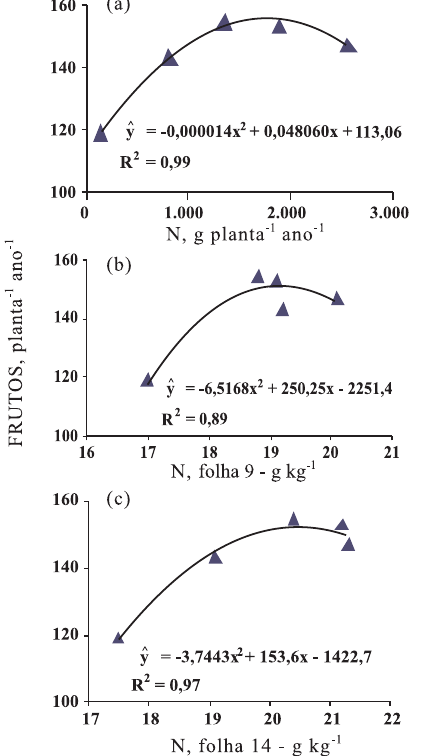
Figura 2. Influência do N na produção de frutos(a) e relação entre o teor foliar de N nas folhas 9 (b) e 14 (c) e a produção de frutos em coqueiros de seis anos de idade.